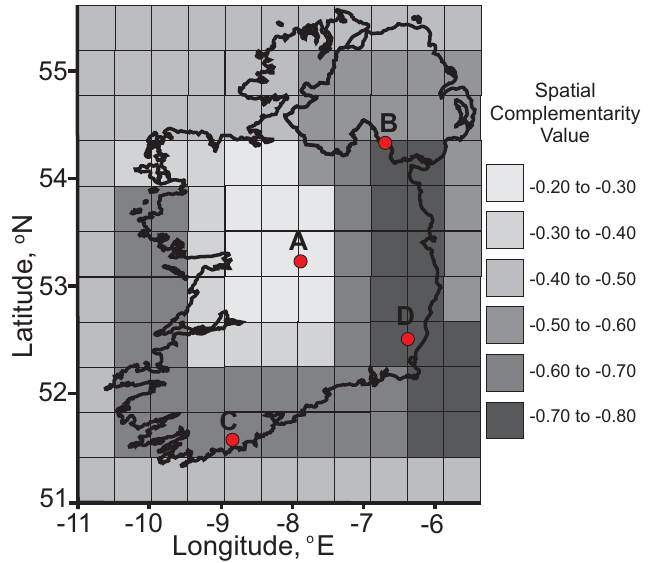
Figure 3. Spatial Complementarity: Map of Ireland showing average complementarity values in different regions. Each of the four labeled sites has a different complementarity